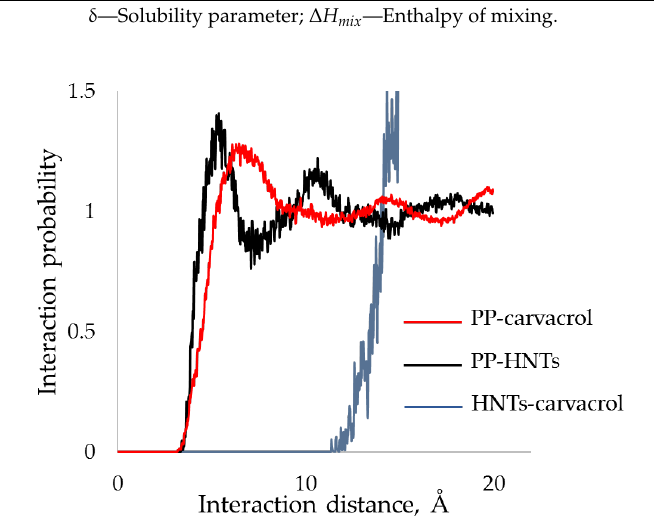
Figure 3. Radial distribution function for different component pairs. The interaction distance between HNTs and carvacrol is much longer compared to PP-carvacrol and PP-HNTs pairs, implying that carvacrol and HNTs only interact separately with PP, with no impact on each other.